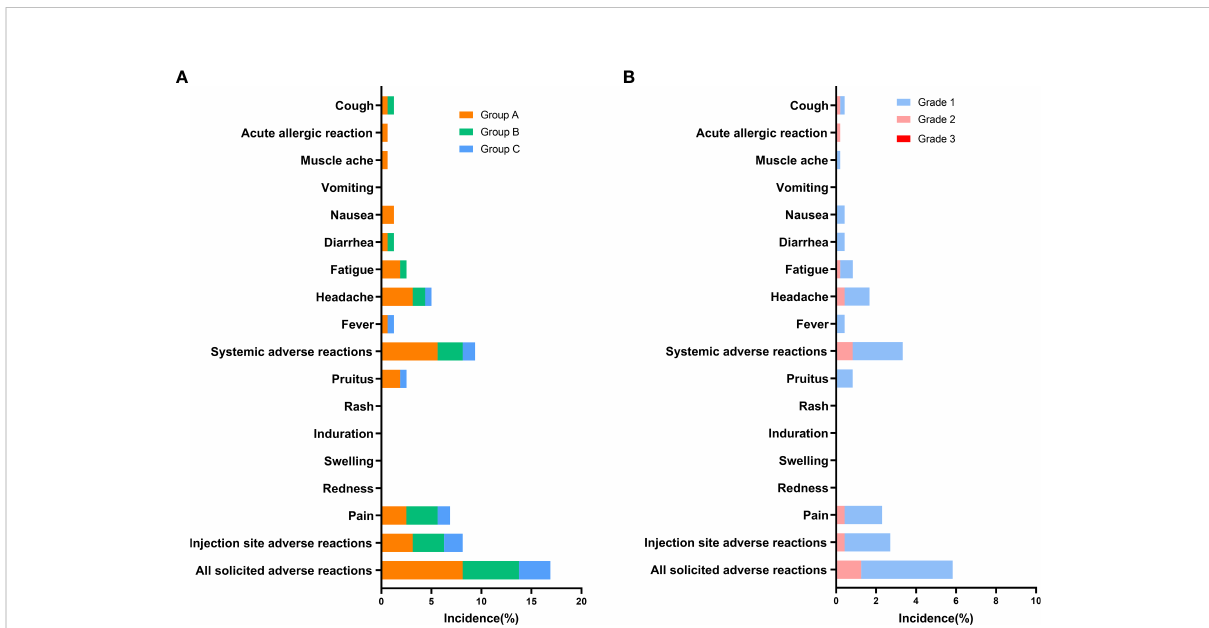
FIGURE 2 Incidence of solicited adverse reactions reported within 30 days after booster dose of ZF2001 (safety analysis population). Adverse reactions refer to adverse events related to the vaccination. (A) Incidence of solicited adverse reactions in groups of different prime-boost time intervals (Group A, B, C). (B) Incidence of solicited adverse reactions of different grades (Grade 1, 2, and 3). Unsolicited adverse reactions are not shown in the fi gure.